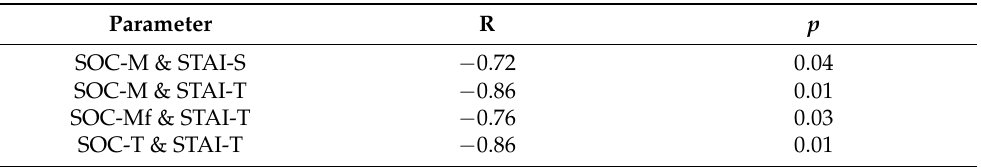
Table 2. Statistically significant correlations between analyzed parameters in urticaria patients manifesting angioedema coexisting wheals.